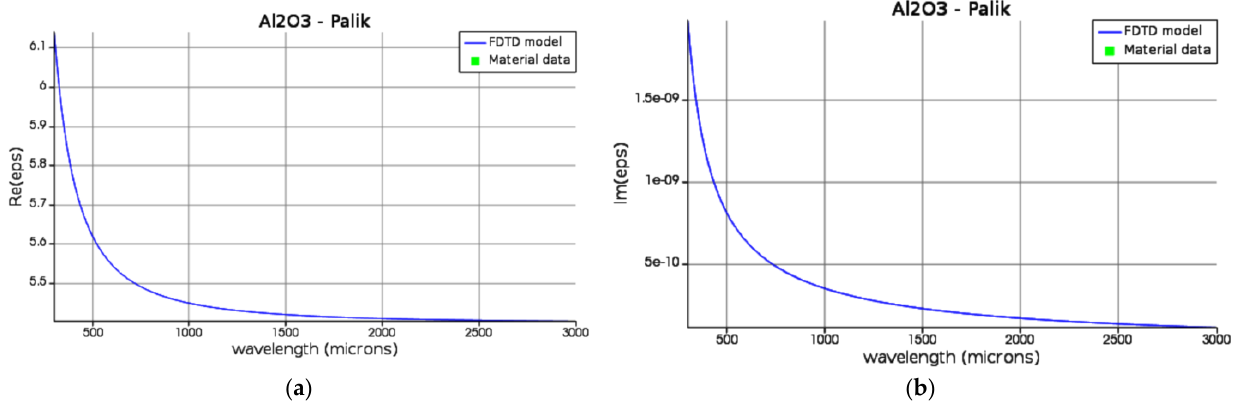
Figure A1. Dielectric constant of Al 2 O 3 : ( a ) The real part of the dielectric constant; ( b ) The imaginary part of the dielectric constant.